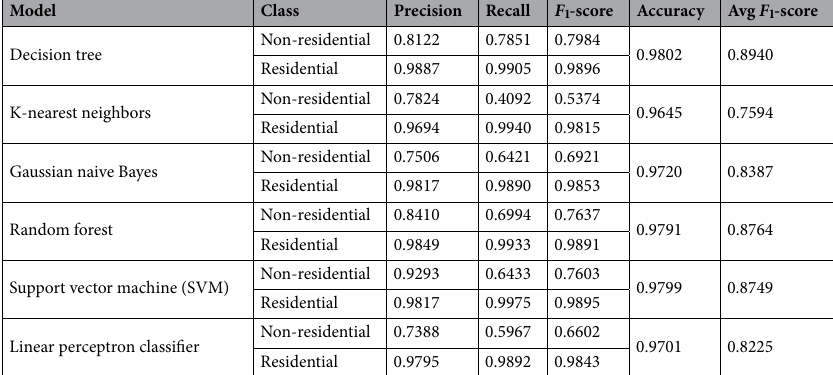
Table 8. Comparison of decision tree with other models using Fairfax